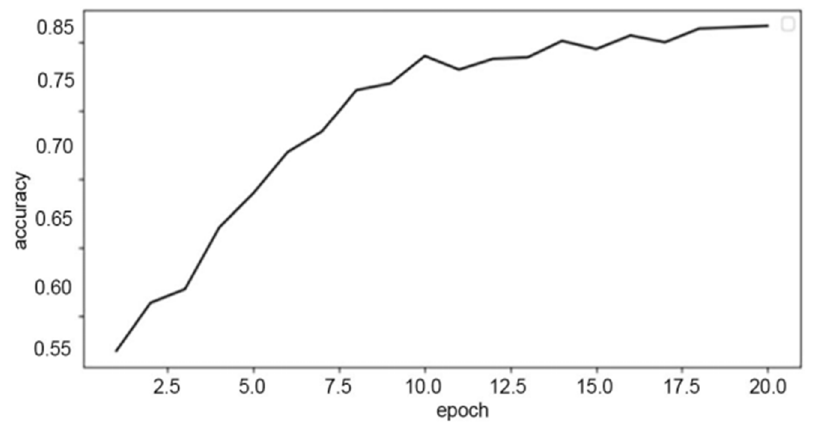
Figure 6. Classification accuracy of the discriminator.